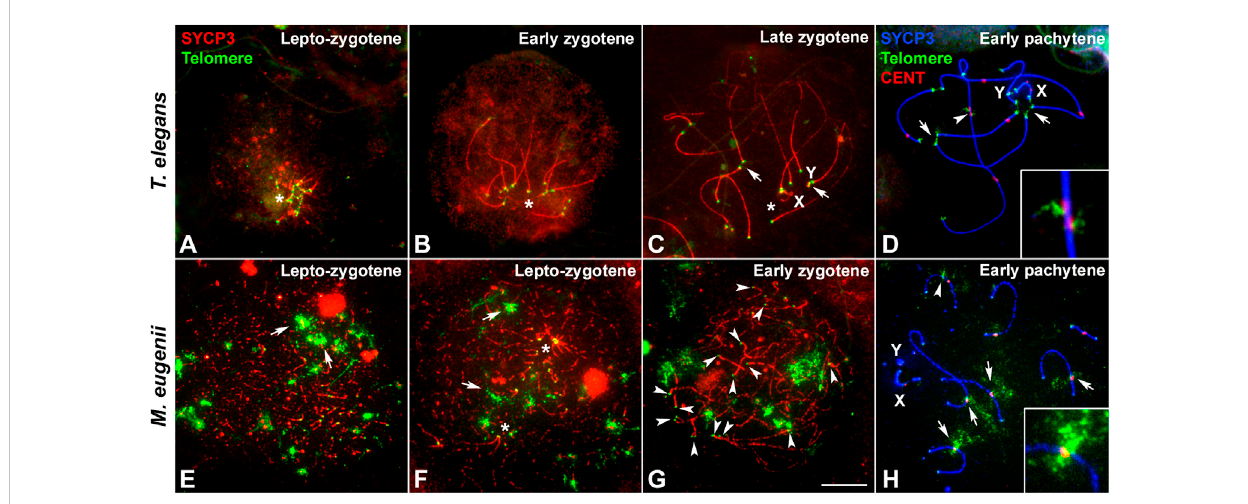
FIGURE 3 Localizationoftelomericsequences in Thylamyselegans and Macropus eugenii . Spreadspermatocytes werelabeled withantibodiesagainst SYCP3 (red)andtelomericsequencesrevealedbyFISH(green)in (A – C) and (E – G) ,andSYCP3(blue),centromericproteins(red)andtelomericsequences(green) in (D) and (H)(A – D) . Thylamyselegans. Telomeresareclustered(asterisks)atthelepto-zygotenetransition (A) andearlyzygotene (B) .Atlatezygotene (C) aslightpolarizationisstillevident(asterisk),andsometelomeresappearassociated(arrows).Atpachytene (D) ,sometelomericassociations(arrows) are occasionally observed. Displacement of interstitial telomeric and centromere signals is evident in the largest bivalent (arrowhead), enlarged in the squared image. (E – H) . Macropus eugenii . At the leptotene-zygotene transition (E,F) telomeric signals (small dots) may appear greatly dispersed (E) or forming several clusters (asterisks in F ). Some large FISH signals are also observed (arrows). Chromosomal ends do not show any speci fi c clustering at early zygotene (G) or at pachytene (H) . Immunolabeling of centromeric proteins (H) reveal that the large FISH signals correspond to interstitial telomeric sequences located at centromeres (arrows) or near centromeres (arrowhead). No displacement of the centromeres or telomeric signal was observed (enlarged imaged in H ). Bar: 10 μ